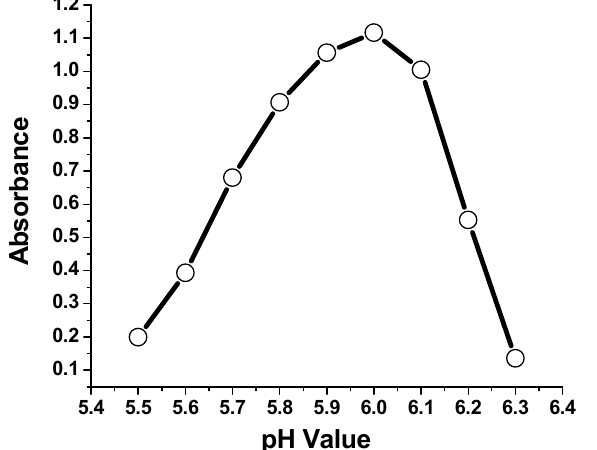
Figure 8. Absorbance intensities at 512 nm for paper strips immersed in aqueous cadmium ions (250 ppm) at different pH values.